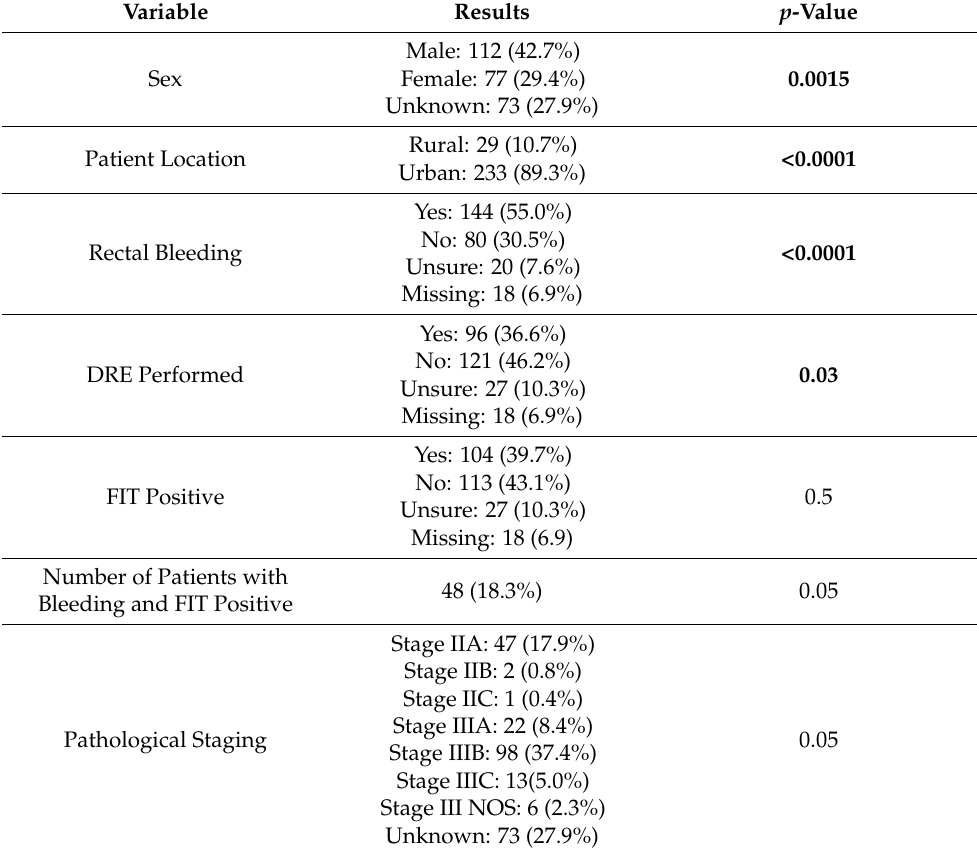
Table 1. Patient characteristics (age, sex, tumor characteristics, FIT positive, percent with rectal bleeding). Statistically significant differences in proportions are bolded ( p < 0.05). p -values were calculated using appropriate univariate